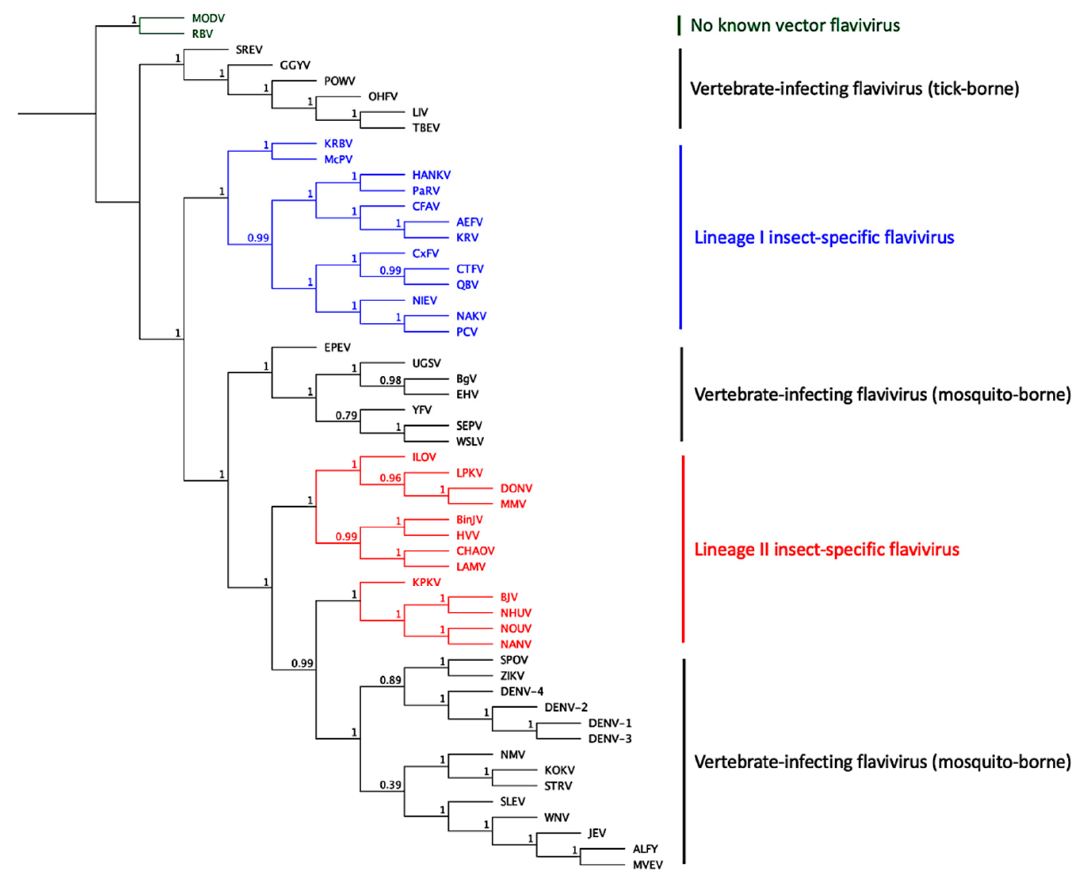
Figure 1. Dendrogram of flavivirus phylogenetic relationships using a maximum-likelihood model and complete amino acid sequences. Sequences were derived using the following GenBank accession numbers: Aedes flavivirus (AEFV AB488408), Alfuy virus (ALFV AY898809), Bamaga virus (BgV KU308380), Binjari virus (BinJV MG587038), Barkedji virus